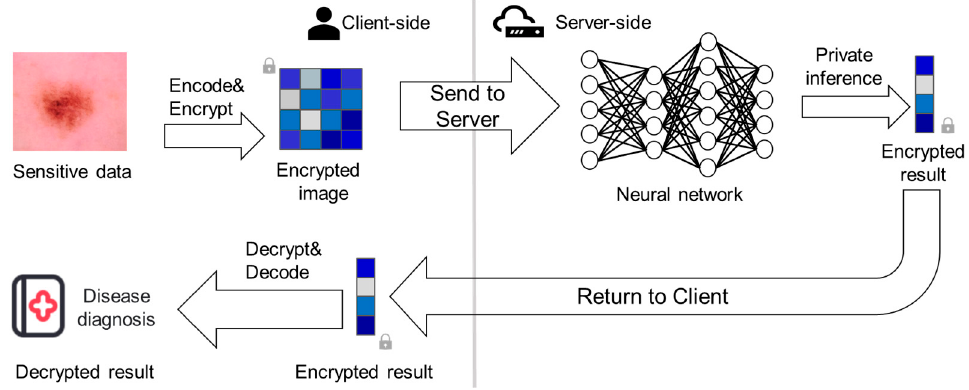
Figure 1. DLaaS based on homomorphic Encryption (Taking the classification of Skin-cancer Images as an example).